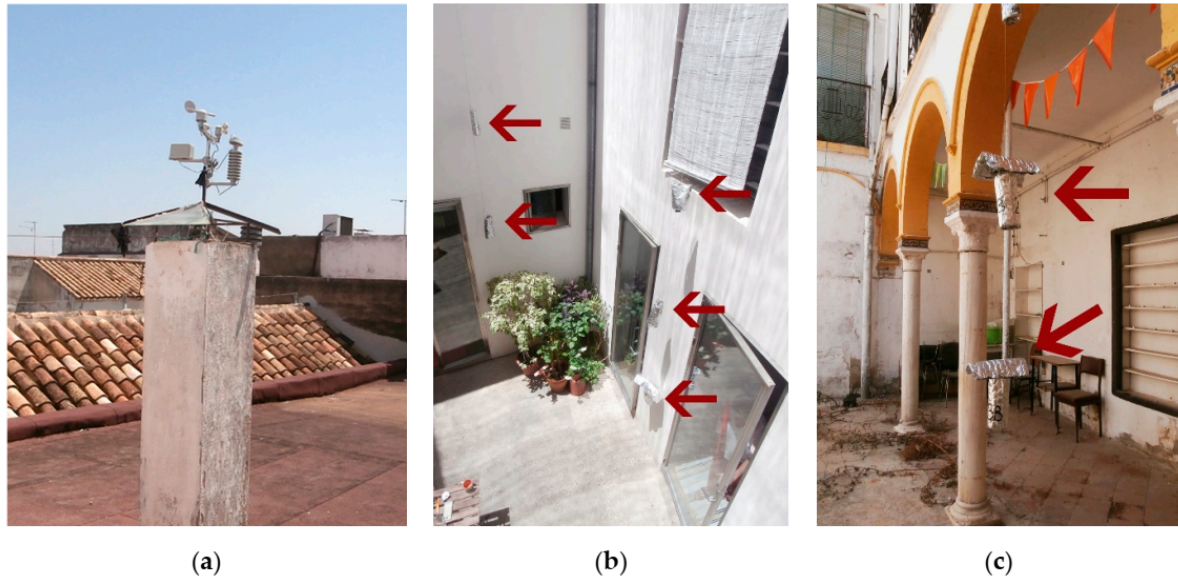
Figure 1. Location of the measurement instruments: ( a ) Weather station PCE-FWS 20; ( b , c ) sensors TESTO